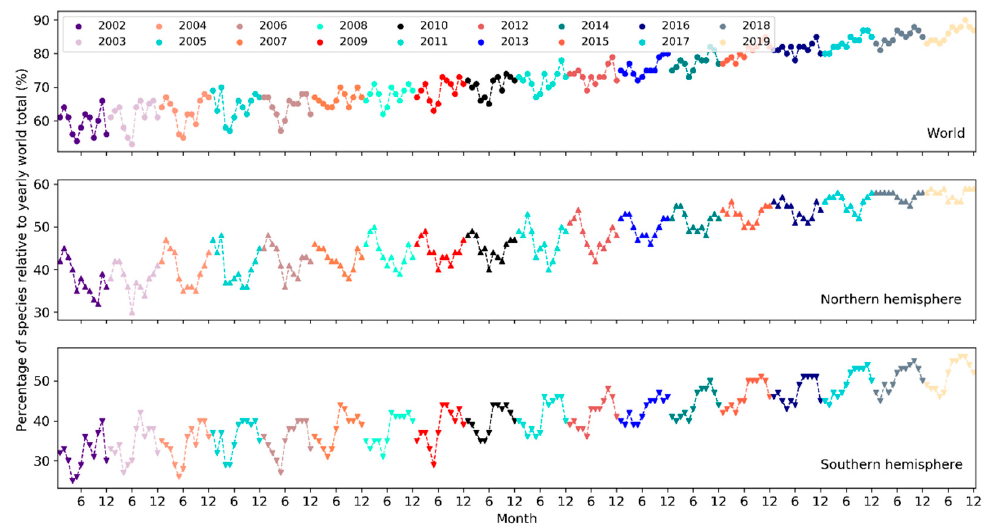
Figure 17. Percentage of species reported in each month relative to the yearly total number of species.